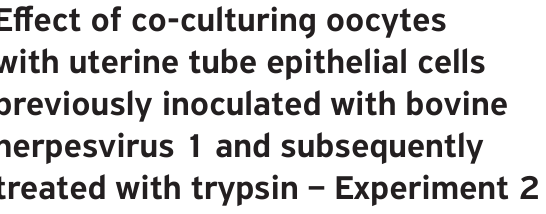
Figure 2. Amplification by nested polymerase chain reaction of BoHV-1 in bovine oocytes pre-inoculated with